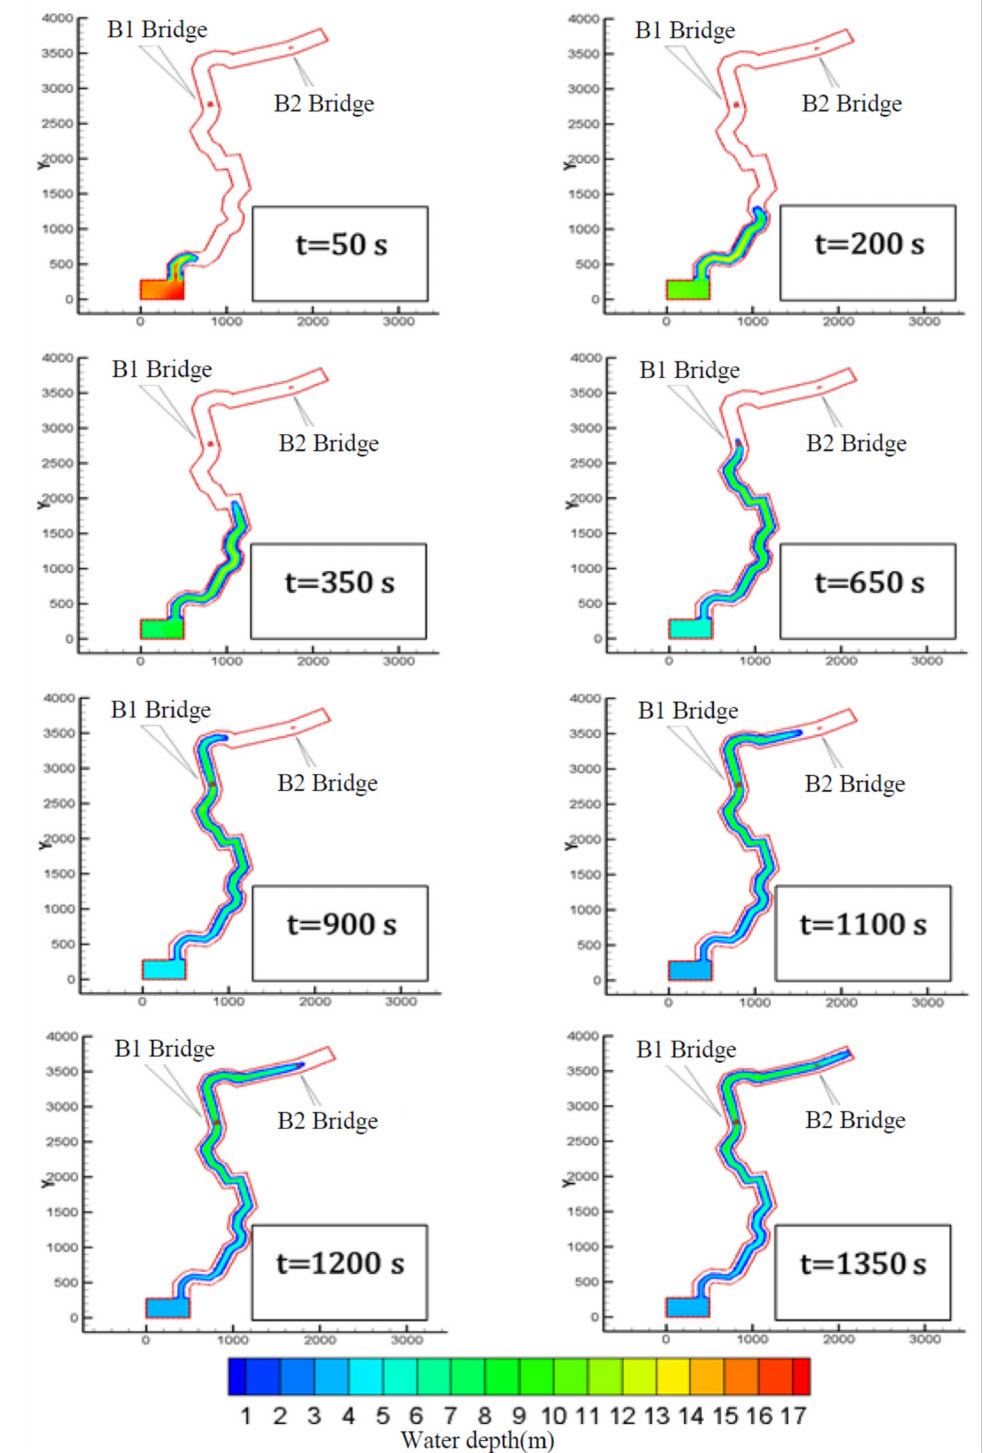
Figure 15. Flooded zoning due to the dam